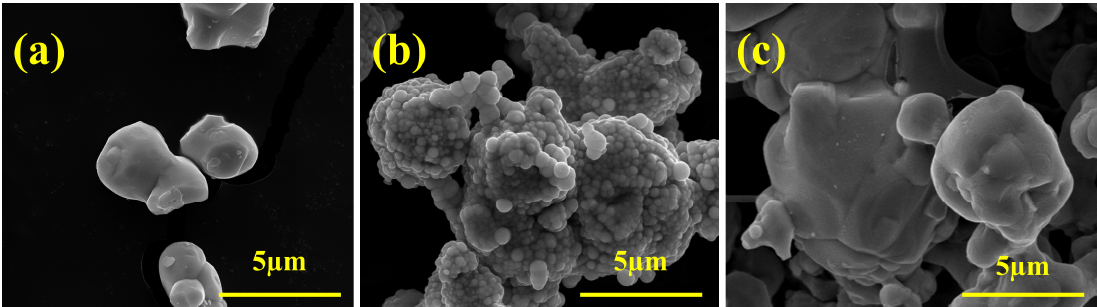
Figure 2. SEM morphology of WC-Ni/Co cemented carbide: ( a ) raw WC; ( b ) WC-Ni/Co EP ; ( c ) WC-Ni/Co CP .